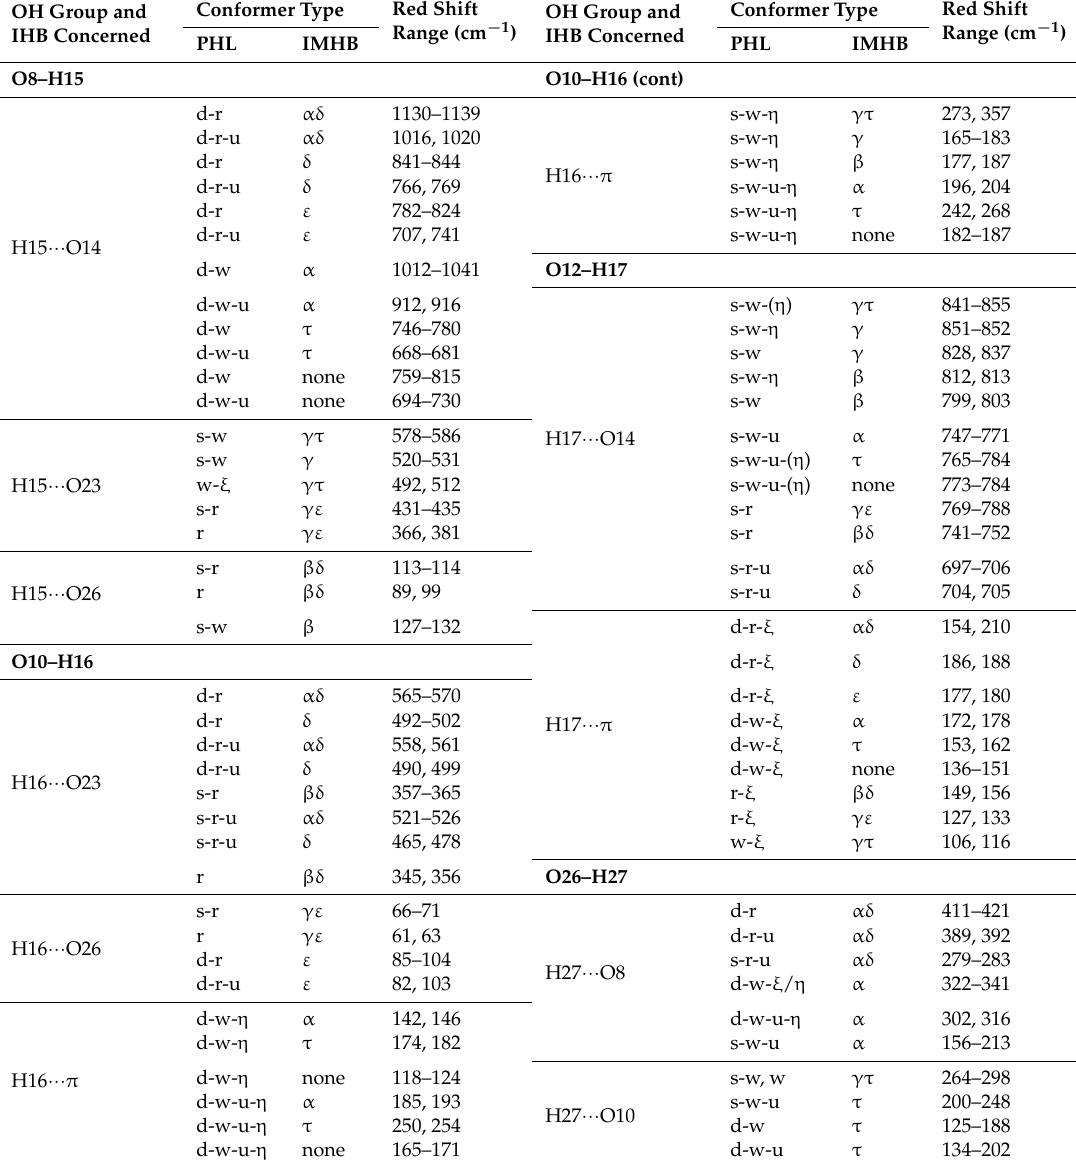
Table 4. Ranges of the red-shifts of the calculated vibrational frequencies (harmonic approximation) of the O-H bonds when they are engaged in intramolecular hydrogen bonds (IHB). DFT/B3LYP/6-31+G(d,p) results in vacuo. The frequency values have been scaled by the factor 0.964, recommended for DFT/B3LYP/6-31+G(d,p) calculations [22]. The red shifts are evaluated with reference to the average frequency of the same OH when not engaged in IHBs, taken from the conformers in which it is free. The types of conformers are characterised by the features that prove relevant in relation to the ranges of the given IHB, i.e., the first IHB and the orientations of the other phenol OHs (under the PHL heading) and the types and combinations of IMHBs (under the IMHB heading). When only two values are available for a given type, they are both reported, separated by a comma. The meaning of a letter being in parentheses in the acronym denoting a conformer, or